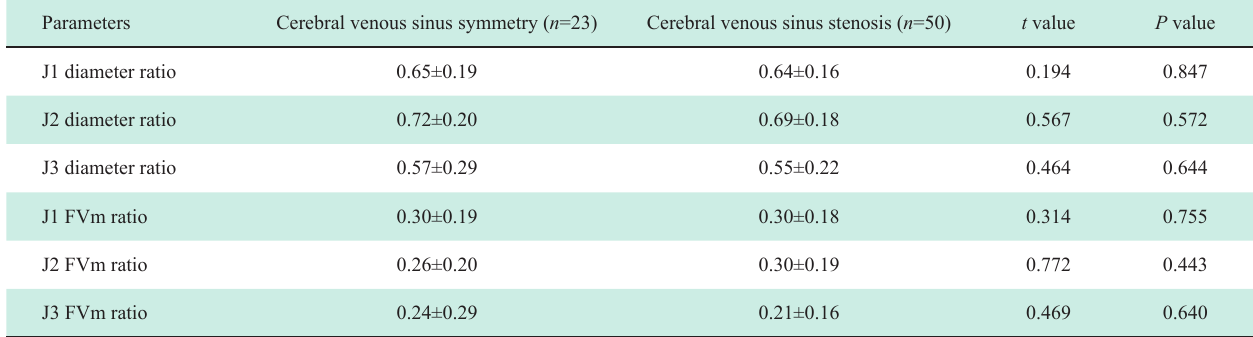
Table 4 The diameter ratio and FVm ratio of IJV between subgroups with and without cerebral venous sinus stenosis